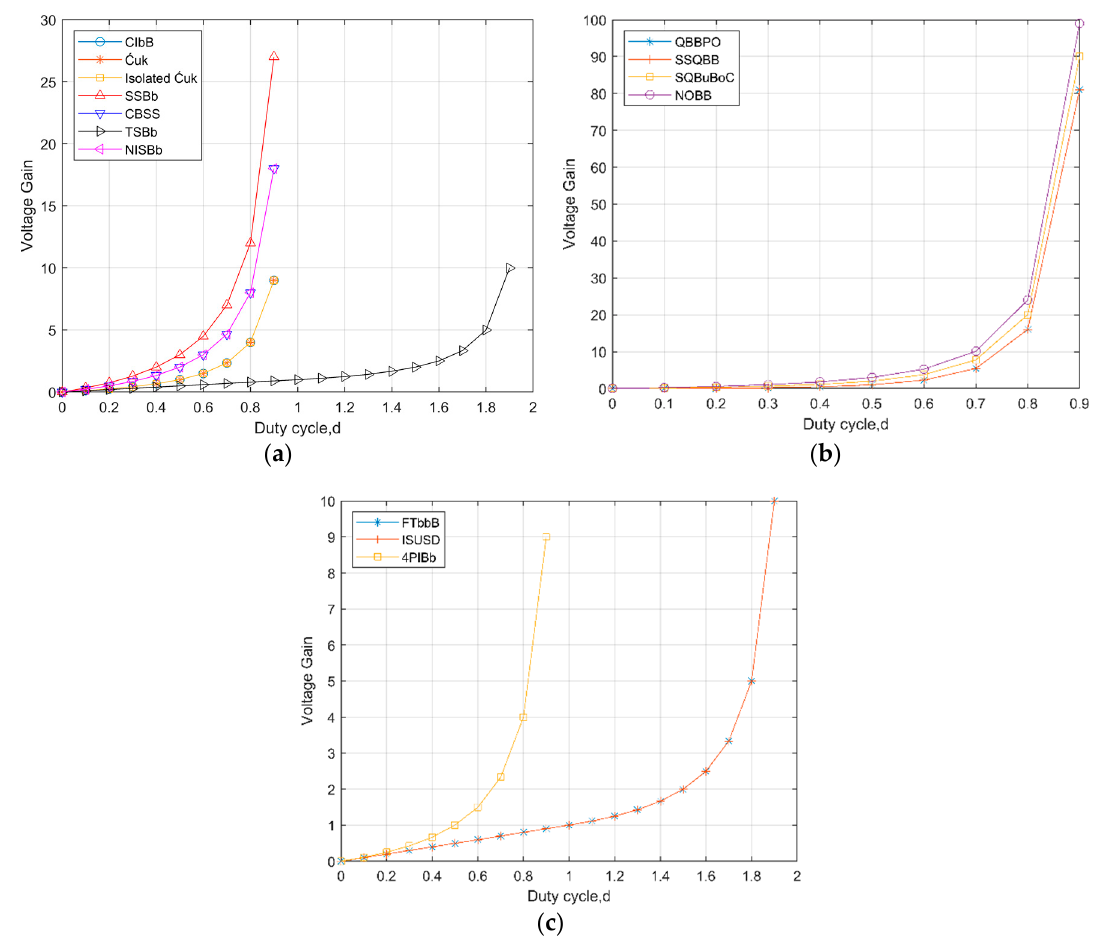
Figure 12. Cuk-based converters voltage gain ( a ). Quadratic converters voltage gain ( b ). Fault-tolerant converters volage gain ( c ).